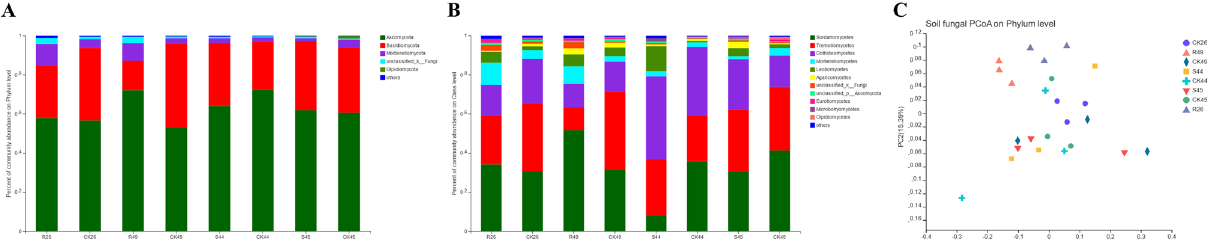
Figure 1. Taxonomic composition of fungal communities in soil at different levels. ( A ) Taxonomic composition of fungal communities at the phylum level, ( B ) Taxonomic composition of fungal communities at the class level, ( C ) Principal coordinate analysis (PCoA) based on Bray–Curtis metrics for fungal communities in soil. ‘Others’ represents the phyla and classes with relative abundances less than 1% of the total sequences. R, resistant variety inoculated with T. controversa ; S, susceptible variety inoculated with T. controversa ; CK, wheat not inoculated with T. controversa ; 26, wheat hybrid variety Mianyang 26/Yumai 47; 49, wheat hybrid variety Yumai 49 * 4/ Lankao dwarf 8; 44, wheat variety A-44; 45, wheat variety Mianyang 26/Yumai 47 and the susceptible variety A-45. For the microorganisms in the roots (Supplementary Table S4), the diversity of all varieties (Shannon: R26, 2.75, R49, 2.93, S44, 2.48, S45, 2.71) was lower in inocu- lated plants than in uninoculated plants (Shannon: CK26, 3.01; CK49, 3.09; CK44, 5.50, CK45, 4.71). At the same time, the abundance of microorganisms in the infected susceptible plants (Ace: S44, 420.47, S45, 427.09; Chao: S44, 284.20, S45, 348.36) was lower than that in the uninoculated plants (Ace: CK44, 1150.13, CK45, 760.22; Chao: CK44, 1073.63, CK45, 650.01). In Supplementary Table S5, the diversity and richness of microorganisms